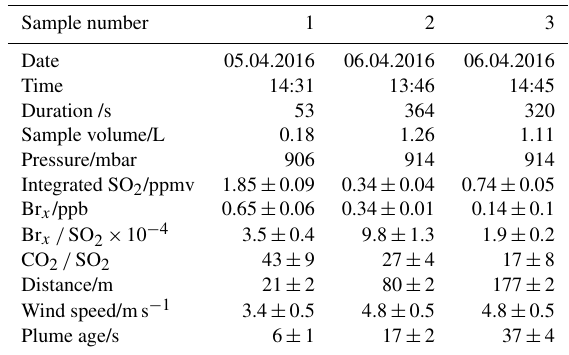
Table 4. Sample parameter and bromine measurement results for three denuder samples at Stromboli